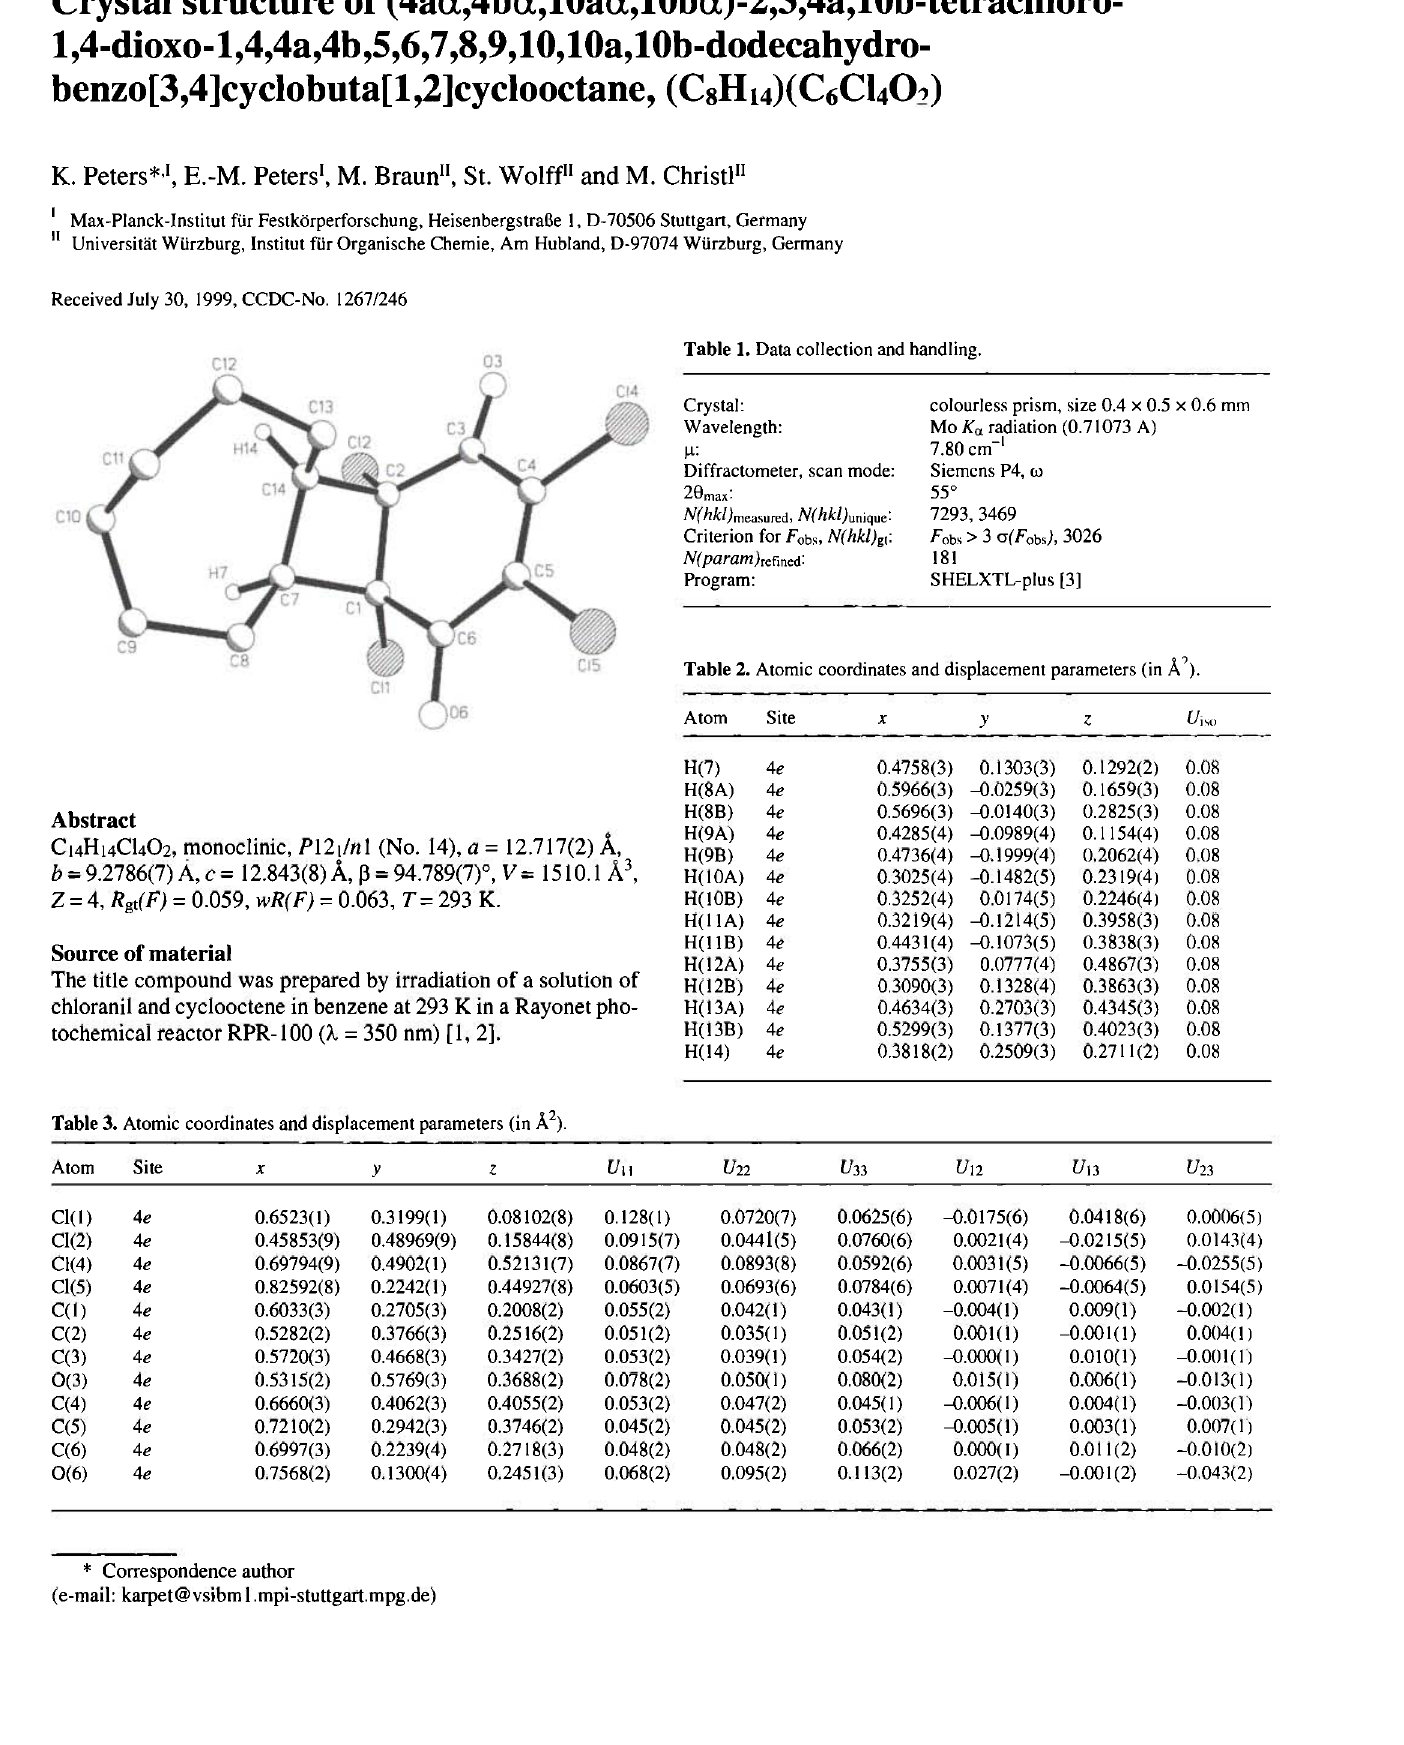
Table 1. Data collection and handling.